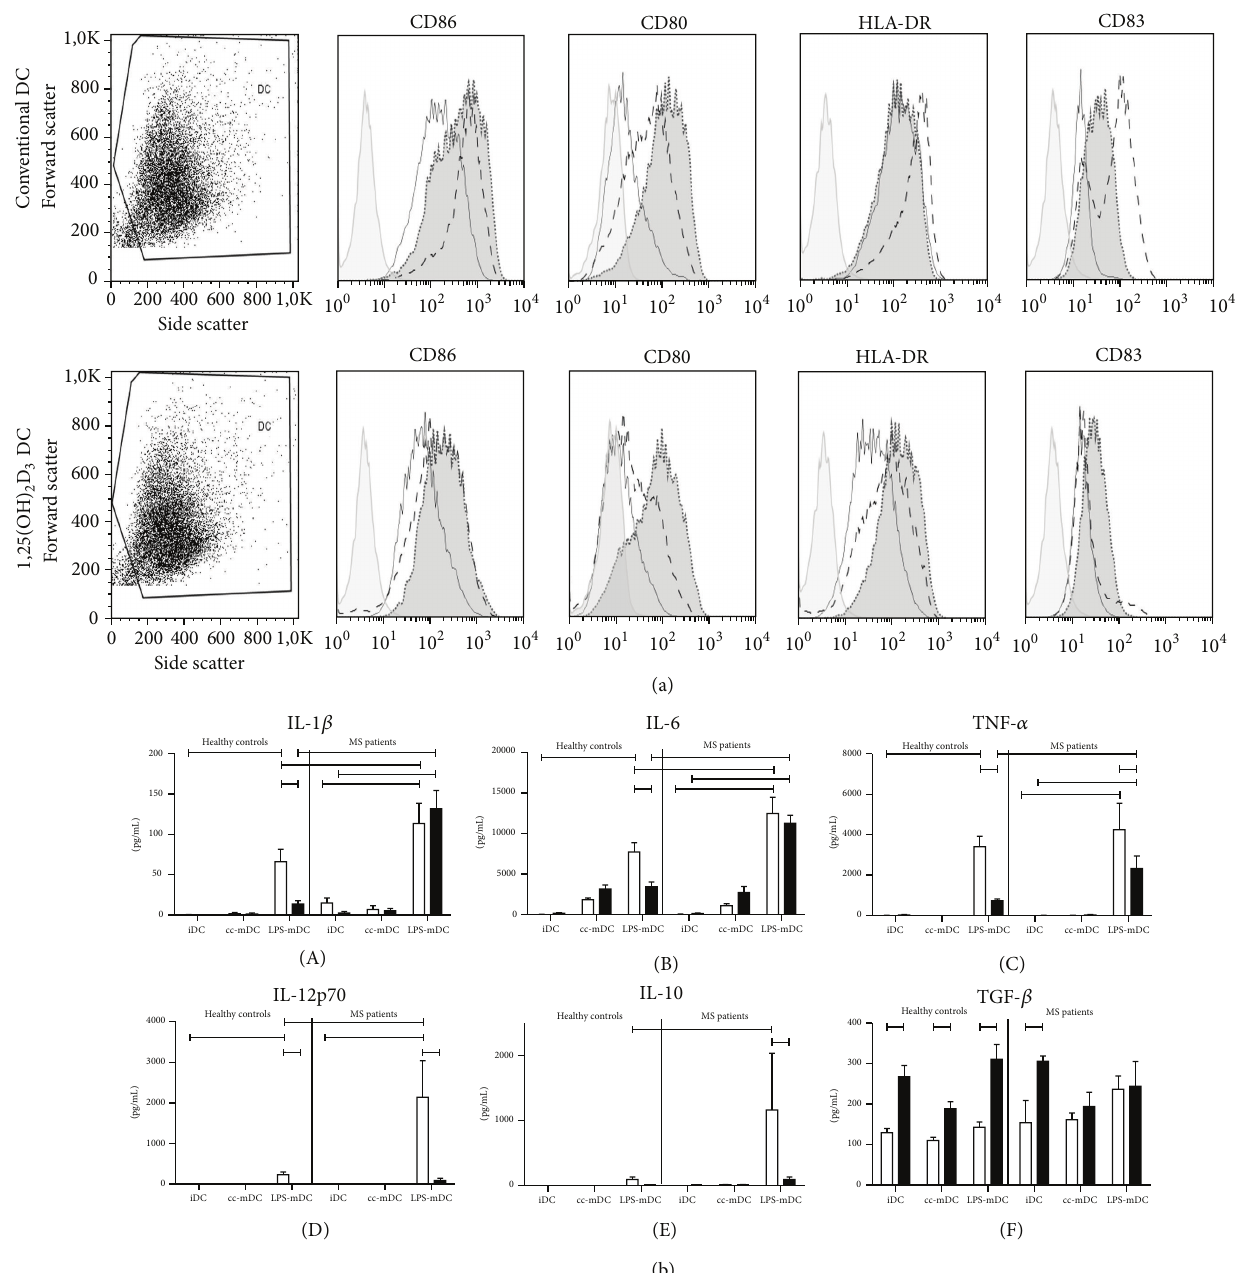
Figure 3: Immunophenotypic analysis and cytokine secretion profile of in vitro differentiated DC from healthy controls and MS patients upon maturation with proinflammatory stimuli. CD14+ monocytes were cultured for 6 days in the presence of IL-4 and GM-CSF or in the presence of IL-4, GM-CSF, and 1,25(OH) 2 D 3 to obtain immature conventional DC (iDC) or 1,25(OH) 2 D 3 -treated iDC, respectively. On day 6, DC were stimulated with a cocktail of proinflammatory cytokines (i.e., cc-mDC) or with LPS and IFN- 𝛾 (i.e., LPS-mDC) or left untreated (i.e., iDC). (a) Representative example showing immunophenotypic analysis of DC. The expression of CD86, CD80, HLA-DR, and CD83 by conventional DC and 1,25(OH) 2 D 3 -treated DC is determined by flow cytometry. Immature DC are represented by a solid line, cc-mDC are represented by a dashed line, and LPS-mDC are represented by a dark grey filled histogram. Isotype-matched controls are represented by the light grey filled histograms. For analysis, DC were gated on light scatter properties as depicted in the forward scatter (FSC) versus side scatter (SSC) dot plot. (b) Cytokine secretion of (A) IL-1 𝛽 , (B) IL-6, (C) TNF- 𝛼 , (D) IL-12p70, (E) IL-10, and (F) TGF- 𝛽 by conventional DC (open bars) and 1,25(OH) 2 D 3 -treated DC (black bars) is determined by a multiplex immunoassay or ELISA. Results are expressed as mean ± SEM (healthy controls: 𝑛 = 7 ; MS patients: 𝑛 = 10